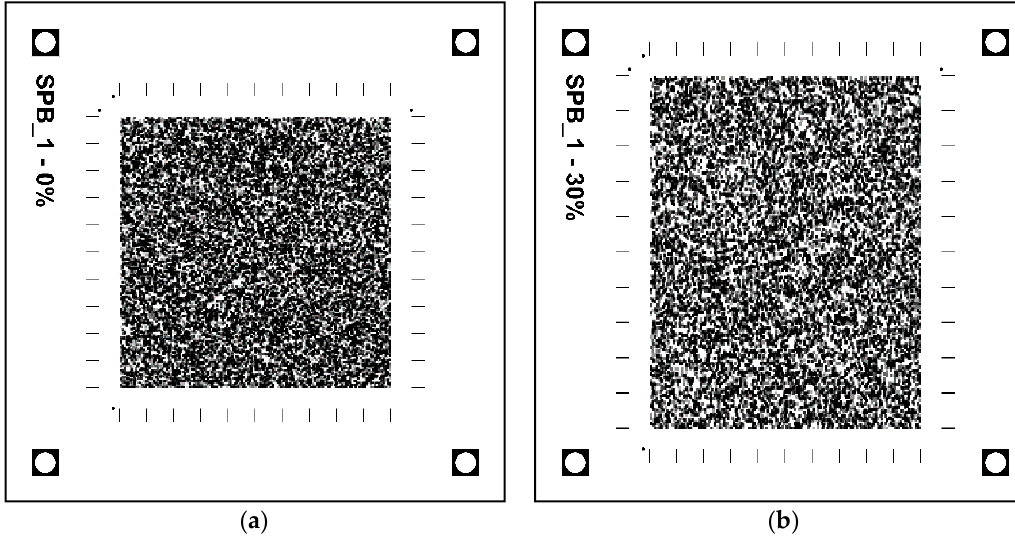
Figure 2. Speckle pattern board (SPB) design for ( a ) 0% and ( b ) 30% strain.